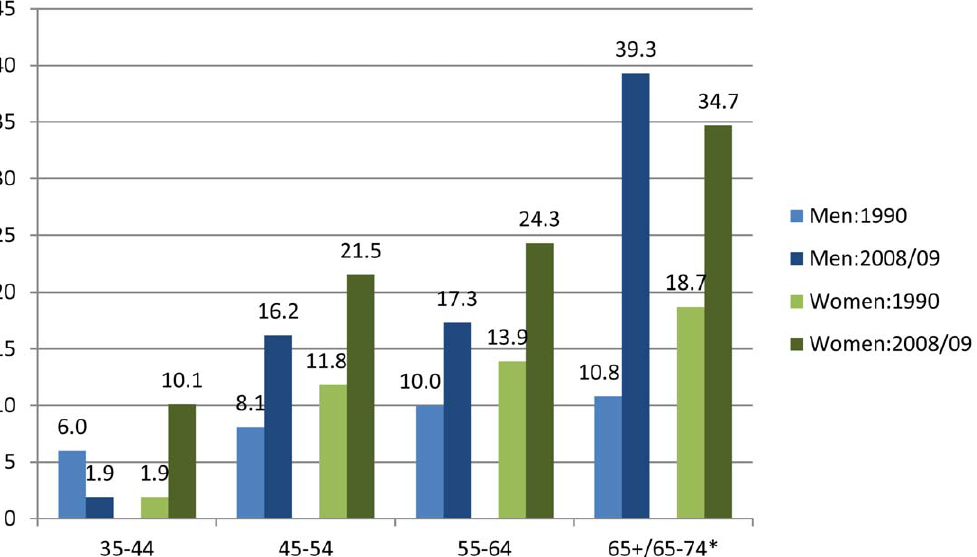
Figure 2. Diabetes prevalence based on 1985 WHO criteria presented by age categories for men and women in 1990 and 2008/09. Footnote: *1990: 65 + years, 2008/09: 65–74 years.